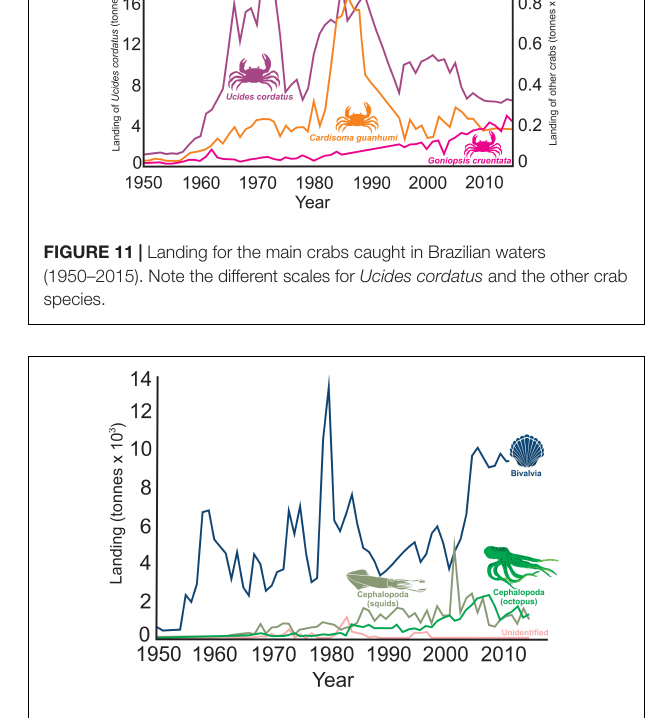
FIGURE 12 | Landing for the main mollusks caught in Brazilian waters